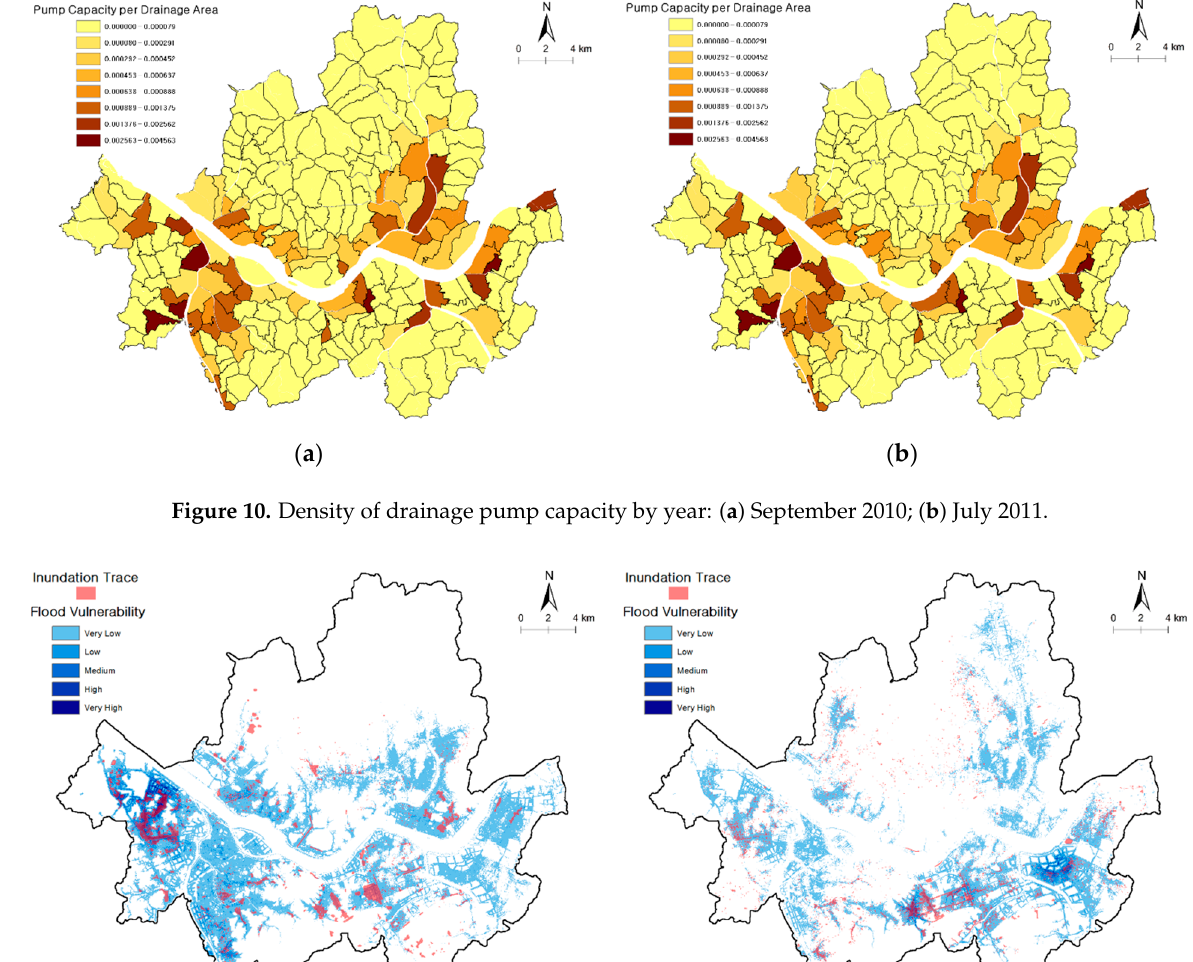
Figure 11. Density of drainage pump capacity by year: ( a ) September 2010; ( b ) July 2011.